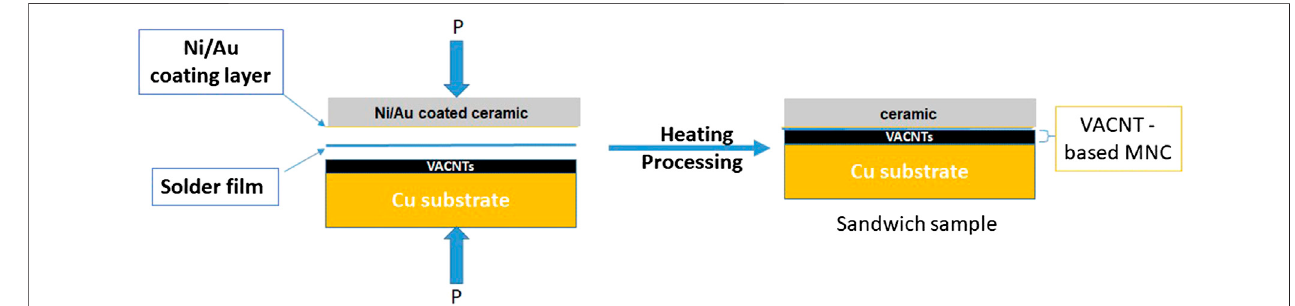
FIGURE 2 | Sandwich sample fabrication process and con fi